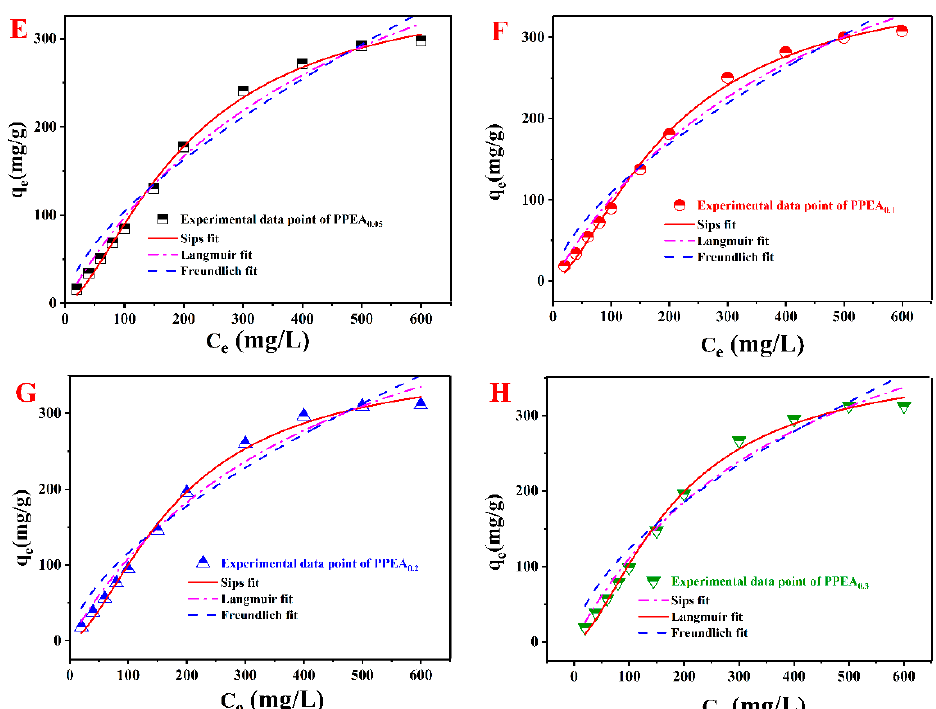
Figure 6. The effect of initial pH ( A ) and contact time ( B ) on the adsorption capacity. The fitting curves with pseudo-first-order and pseudo-second-order kinetic models ( C ), as well as the intra- particle diffusion model ( D ). The adsorption isotherm curves of PPEA 0.05 ( E ), PPEA 0.1 ( F ), PPEA 0.2 ( G ), and PPEA 0.3 ( H ) as fitted using the Langmuir, Freundlich, and Sips models.